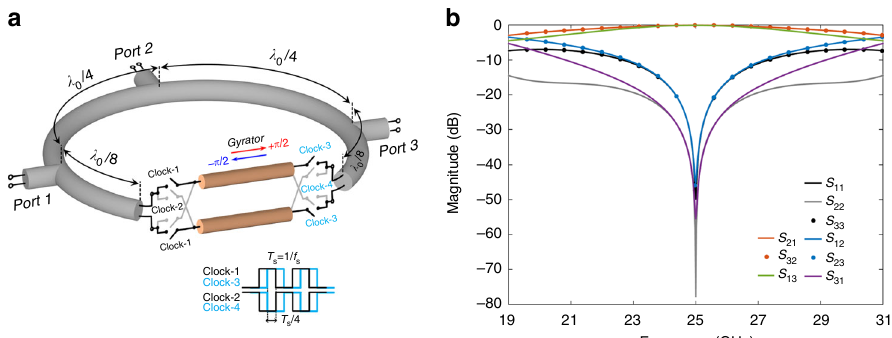
Fig. 4 Millimeter-wave circulator based on conductance modulation. a Schematic of the circulator: three λ /4 transmission line sections with ports in between are wrapped around the ideal gyrator that is shown in Fig. 3a. The gyrator is designed to provide a non-reciprocal ± π /2 phase shift at 25 GHz via modulation at 8.33 GHz. For the sake of symmetry, the gyrator is placed in the middle of one λ /4 section. b Analytically computed scattering parameters for the circulator